Question: Describe this figure in one sentence.
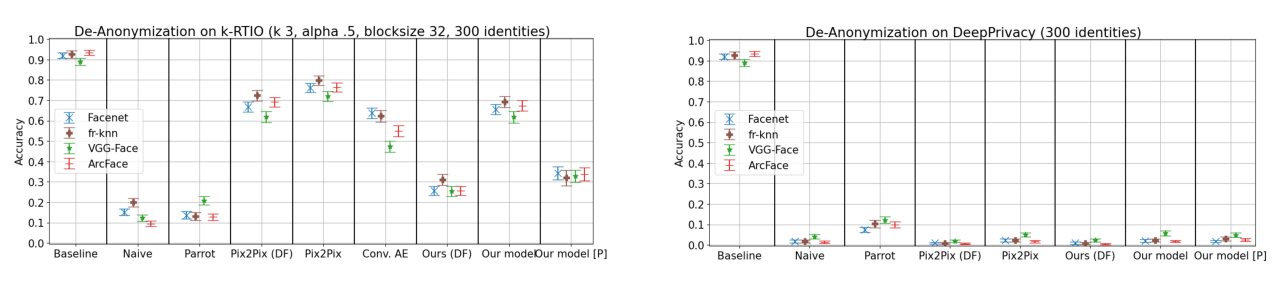
Answer: Recognition accuracy for DeepPrivacy, given for baseline, naive, parrot, de-anon. via Pix2Pix trained on DigiFace-1M, via Pix2Pix, via our model trained on DigiFace- 1M, via our model; on 300 identities of CelebA.